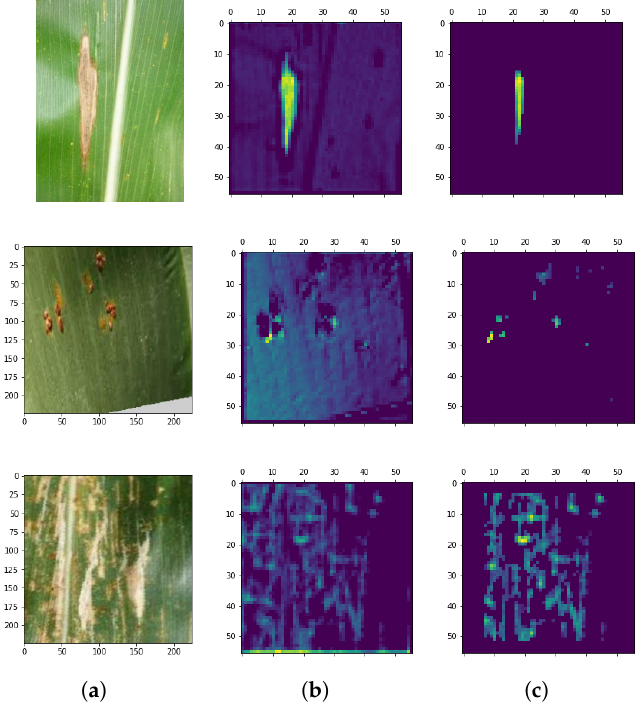
Figure 9. Examples of maize leaf images from the PlantVillage dataset. The dataset contains the following classes: ( a ) Raw RGB color images—Top: Blight; Middle: Common Rust; and Bottom: Gray spot. ( b ) Covnet image, deep feature visualization. The heatmap output of Covnet contains the ROI as well as the background. ( c ) Adaptive threshold performance. Result of adaptive